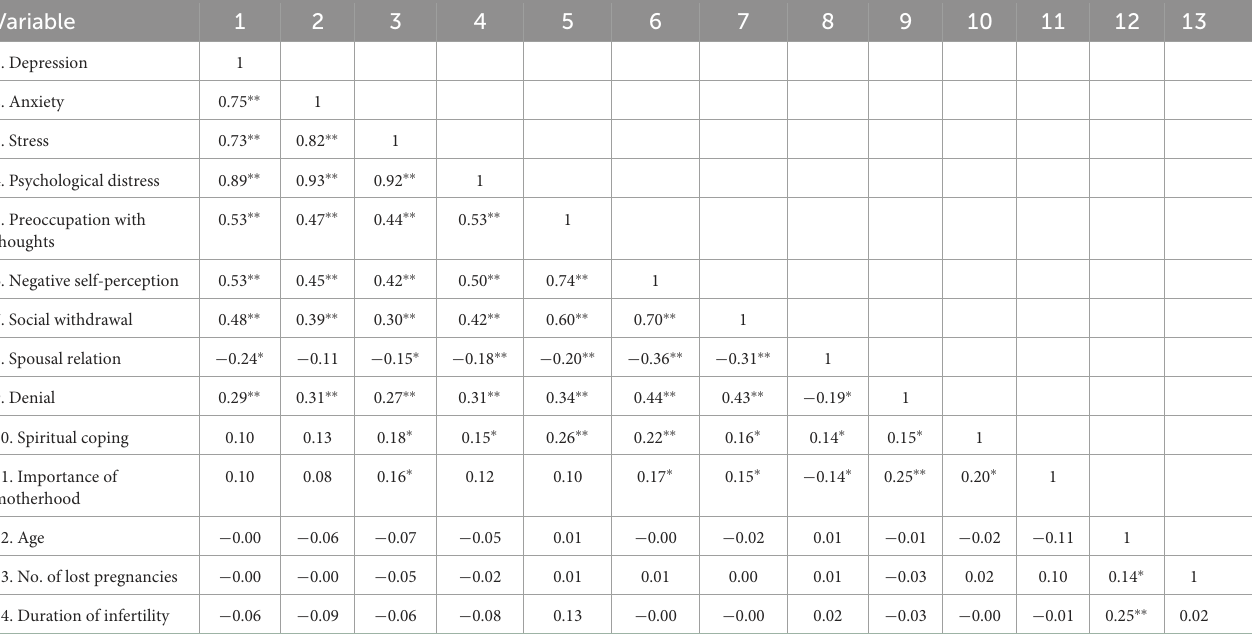
TABLE 3A Zero-order correlations among the main variables—overall sample ( N =